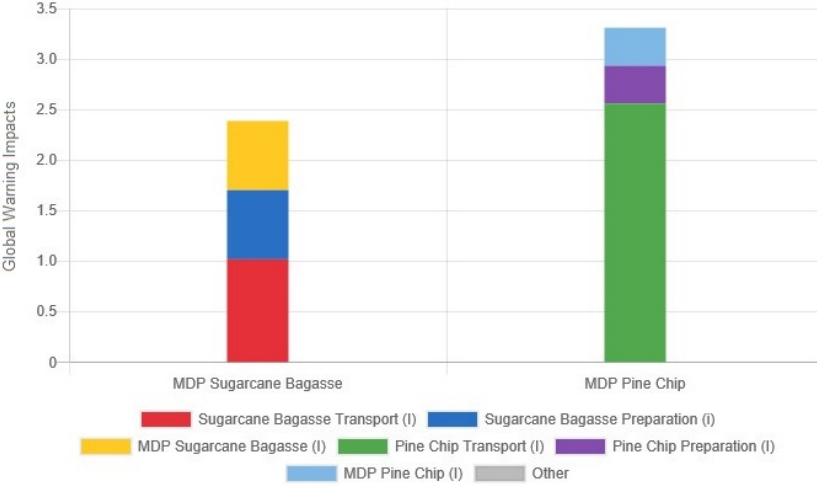
Figure 5. Global warming impacts (kg CO 2 eq).